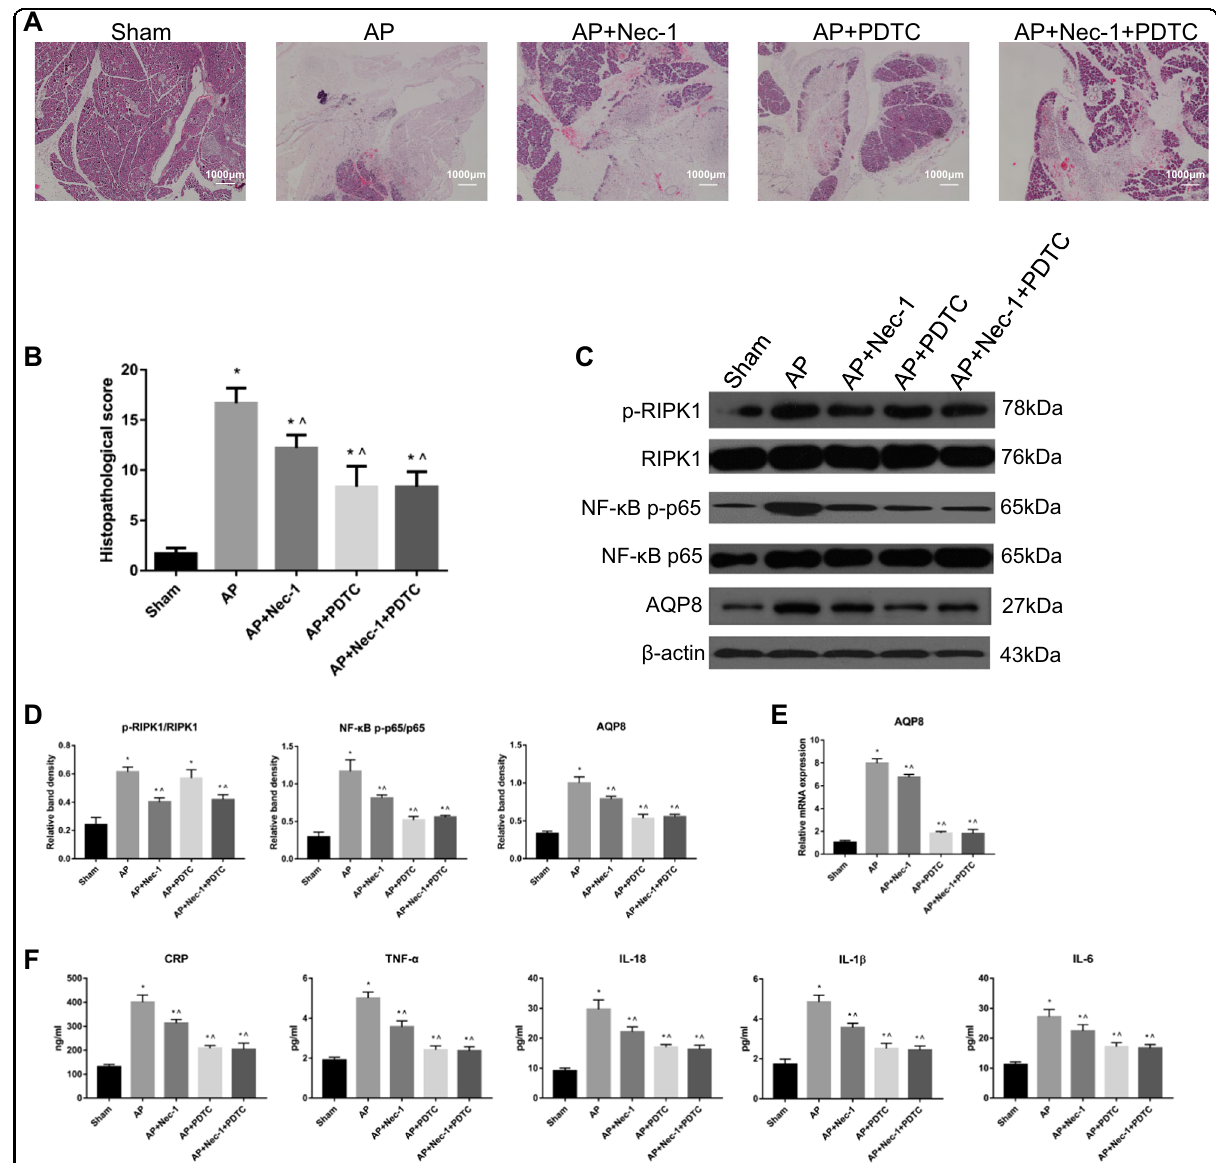
Fig. 8 A RIPK1/NF- κ B p65/AQP8 axis might exist during AP in rats. a Representative images (4×) of hematoxylin and eosin-stained pancreatic tissues harvested from rats subjected to sham operation, AP, AP + Nec-1, AP + PDTC or AP + Nec-1 + PDTC for 24 h after AP induction. b Histopathological scoring was performed to evaluate pancreatic injury in the rats described above. c Representative immunoblot images and d quantitation of the p-RIPK1/RIPK1, NF- κ B p-p65/p65, and AQP8 levels in pancreatic tissues harvested from the rats described in Fig. 8a. β -Actin was used as the protein loading control. e Relative mRNA expression of AQP8 in pancreatic tissues harvested from the rats described in Fig. 8a. f The levels of CRP, TNF- α , IL-18, IL-1 β , and IL-6 in peripheral blood samples harvested from the rats described in Fig. 8a were spectrophotometrically measured. The data are the means ± S.Ds. ( n = 3). * P < 0.05 versus sham, ^ P < 0.05 versus